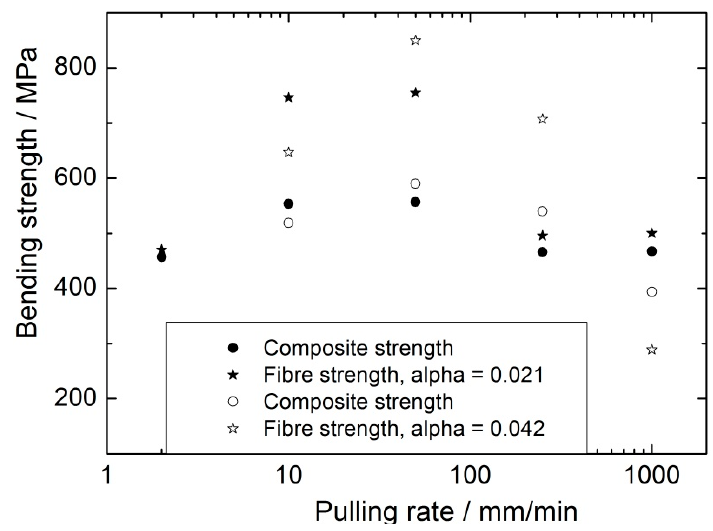
Figure 10. Strength of specimens of type I and reinforcing fibres versus crystallisation rate. Solid and open points represent the composites containing fibres obtained from the raw oxide mixtures with α = 0.021 and 0.042, respectively.